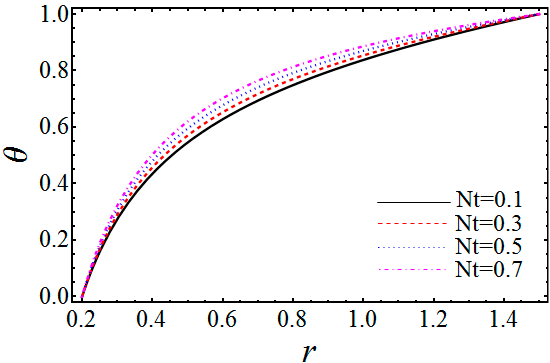
Figure 10. Variation of temperature profile θ with Nt for fixed θ = 0.1, ϕ = 0.5, δ = 0.1, ε = 0.1, V = 0.3, λ 1 = 1, z = 0, t = 0.3, Nb = 0.2, Br = 0.5.